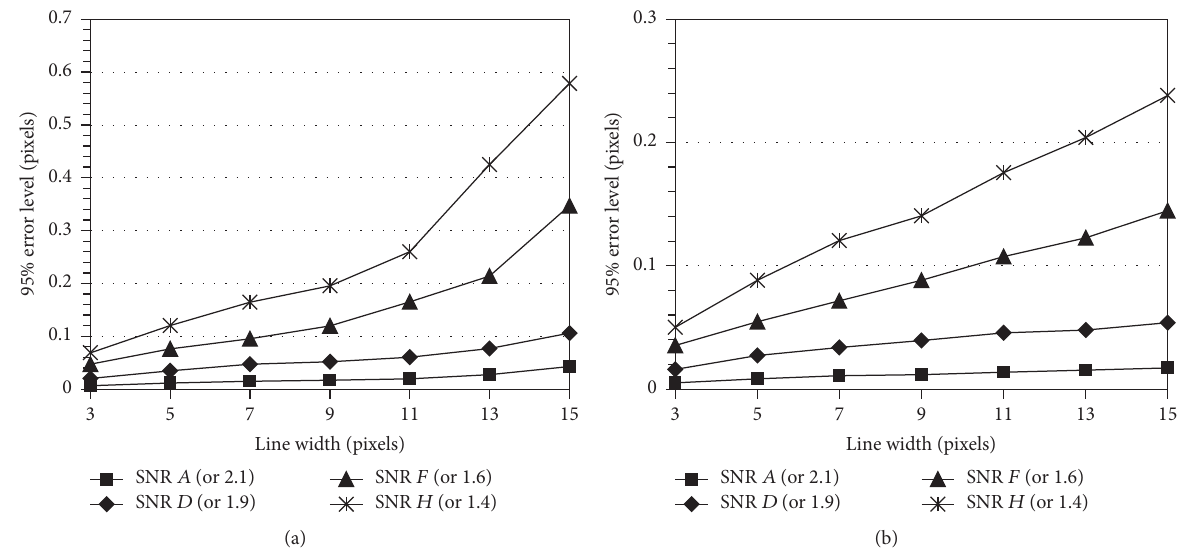
Figure 9: Displacement error levels (without filtering) for different SNR values and various line widths using a source window size: (a) 15 × 15 and (b) 27 ×